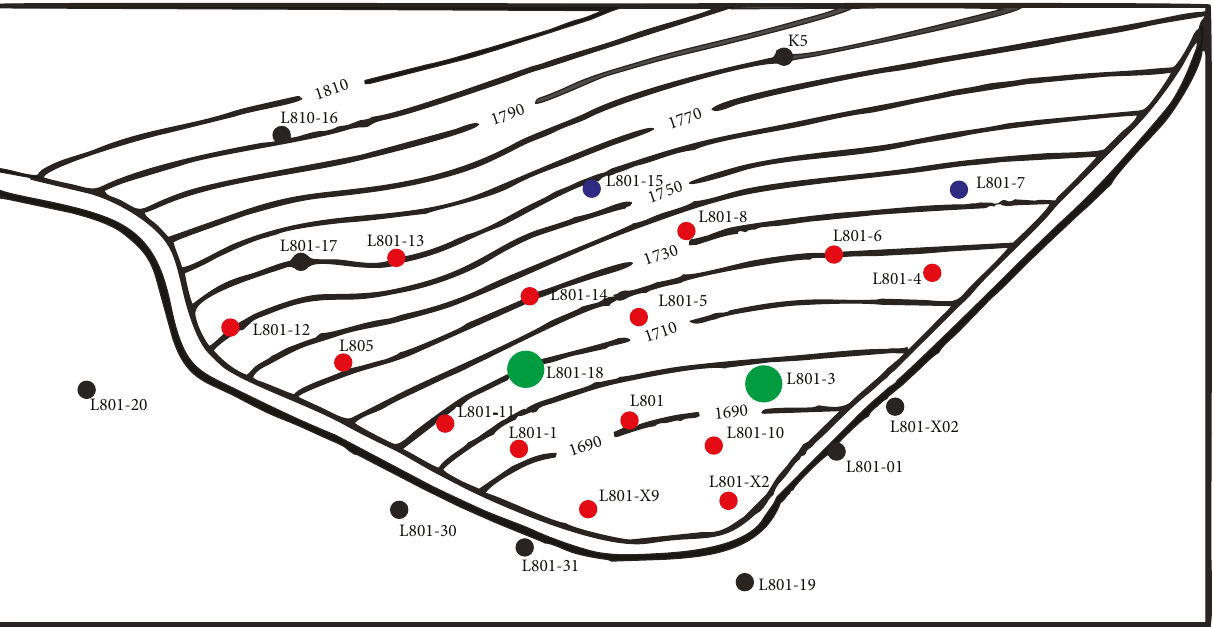
Figure 13: Luo 801 Block in Shengli Oil fi eld MEOR fi eld test